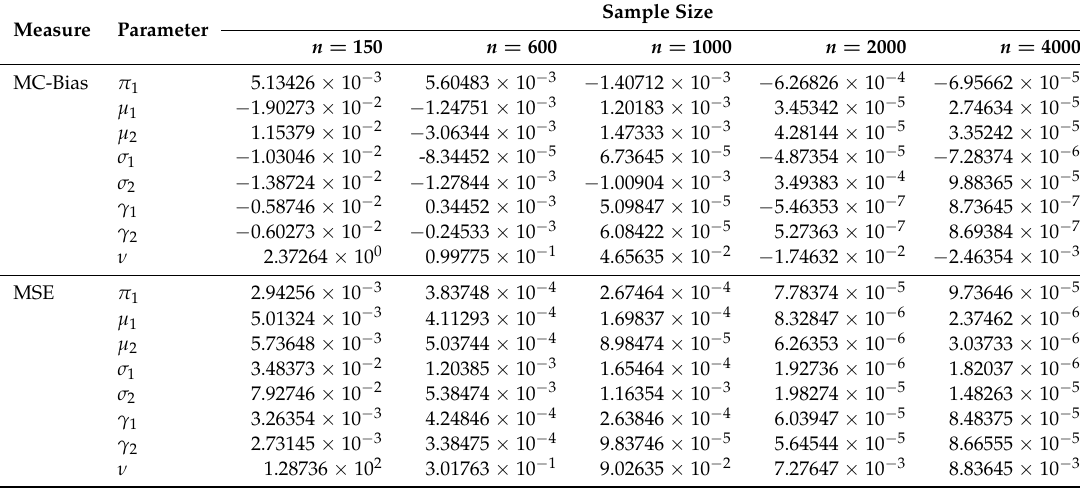
Table 5. MC-Bias and MSE for ML estimates estimates in the strong separated components (SS) FM-TP-T